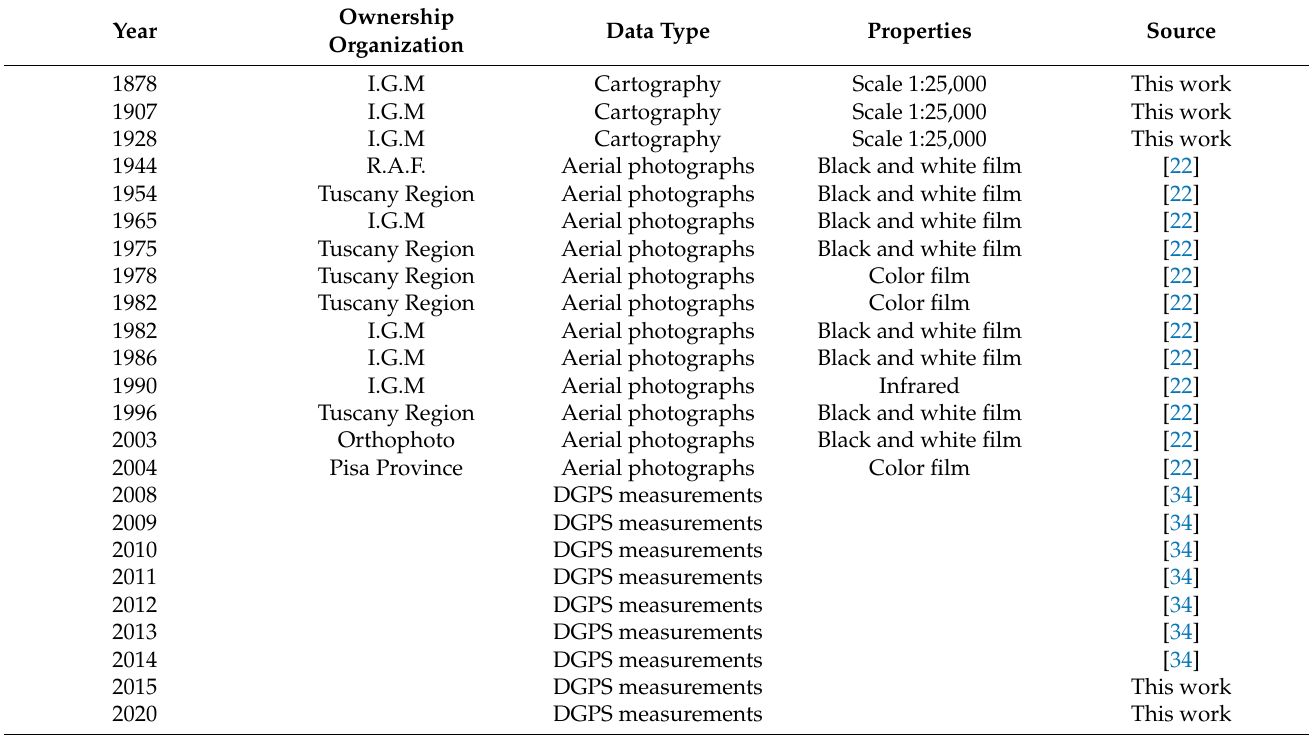
Table 1. Census of shoreline data used in this